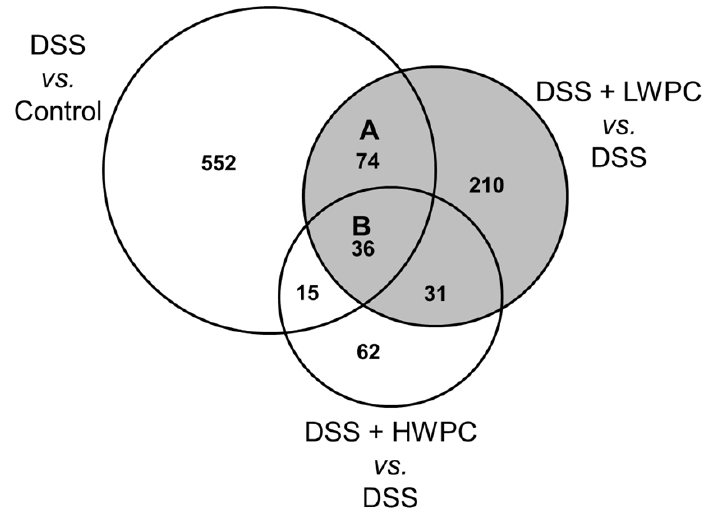
Figure 4. Venn diagram of differentially-regulated genes. Numbers show genes up- or down-regulated (≥2-fold), compared between the control (no treatment) and DSS, between DSS and DSS + LWPC and between DSS and DSS + HWPC